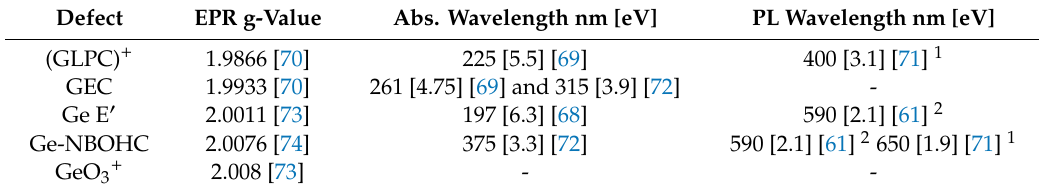
Table 2. Common defects found in germanate glasses, their EPR values, and absorption bands. Defect EPR g-Value Abs. Wavelength nm [eV] PL Wavelength nm [eV] (GLPC) + 1.9866 [70] 225 [5.5] [69] 400 [3.1] [71] 1 GEC 1.9933 [70] 261 [4.75] [69] and 315 [3.9]